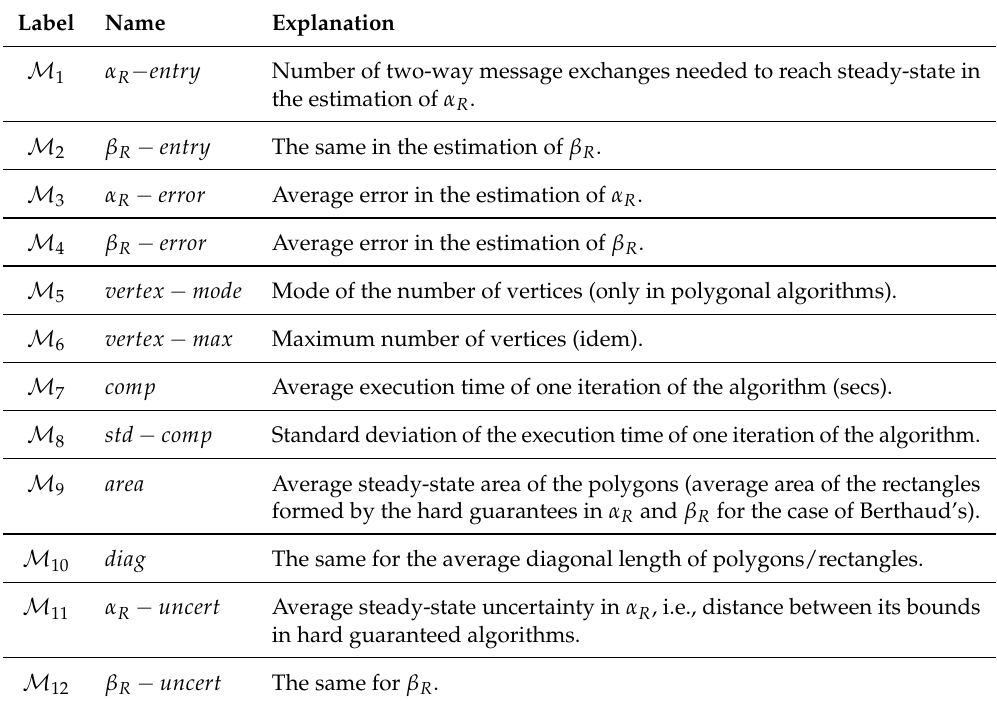
Table 2. Performance measures calculated in each